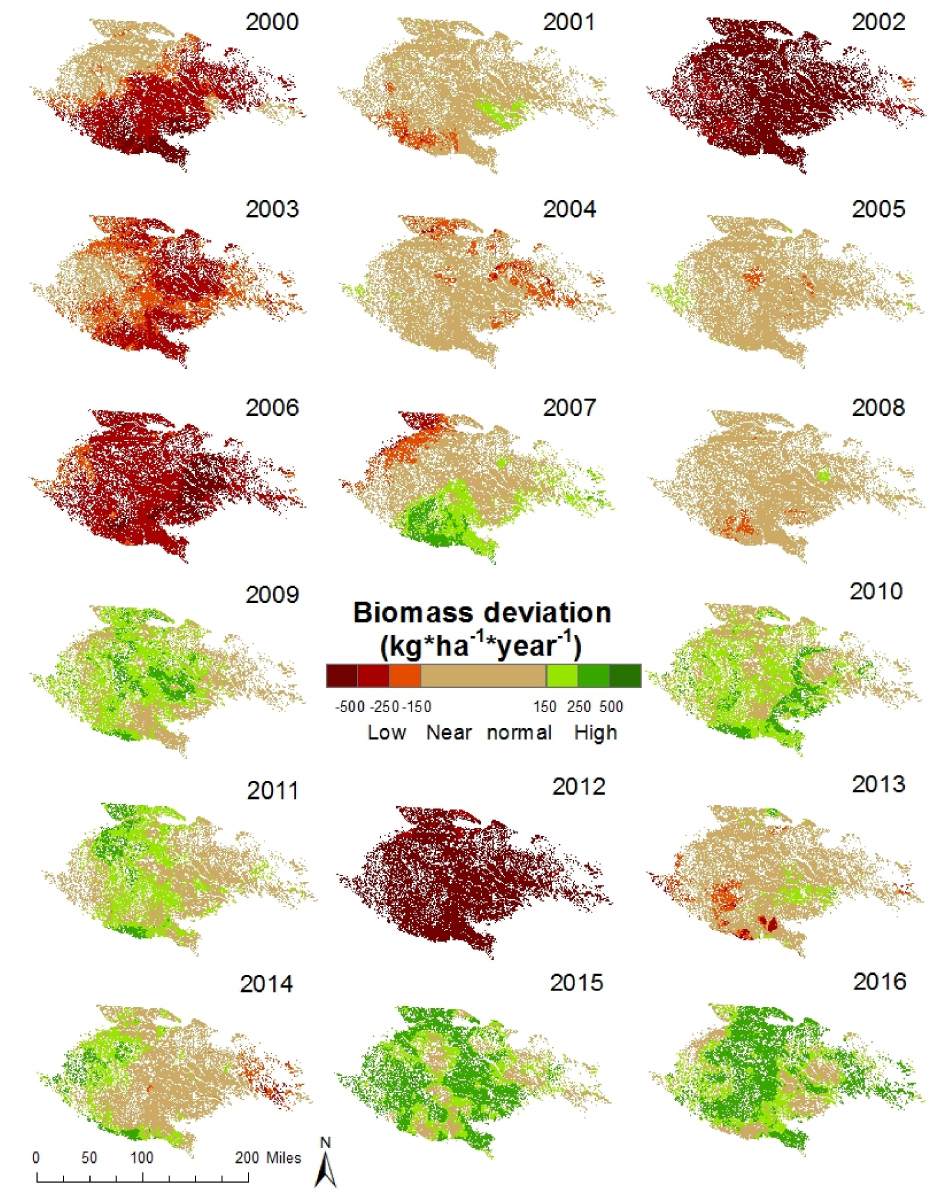
Figure 5. Annual biomass deviation maps developed for the Sandhills MLRA from 2000 to 2016. Sandhills MLRA was masked to include only the desired grassland areas. Green colors represent significant positive deviation from long-term median, while red colors represent significant negative